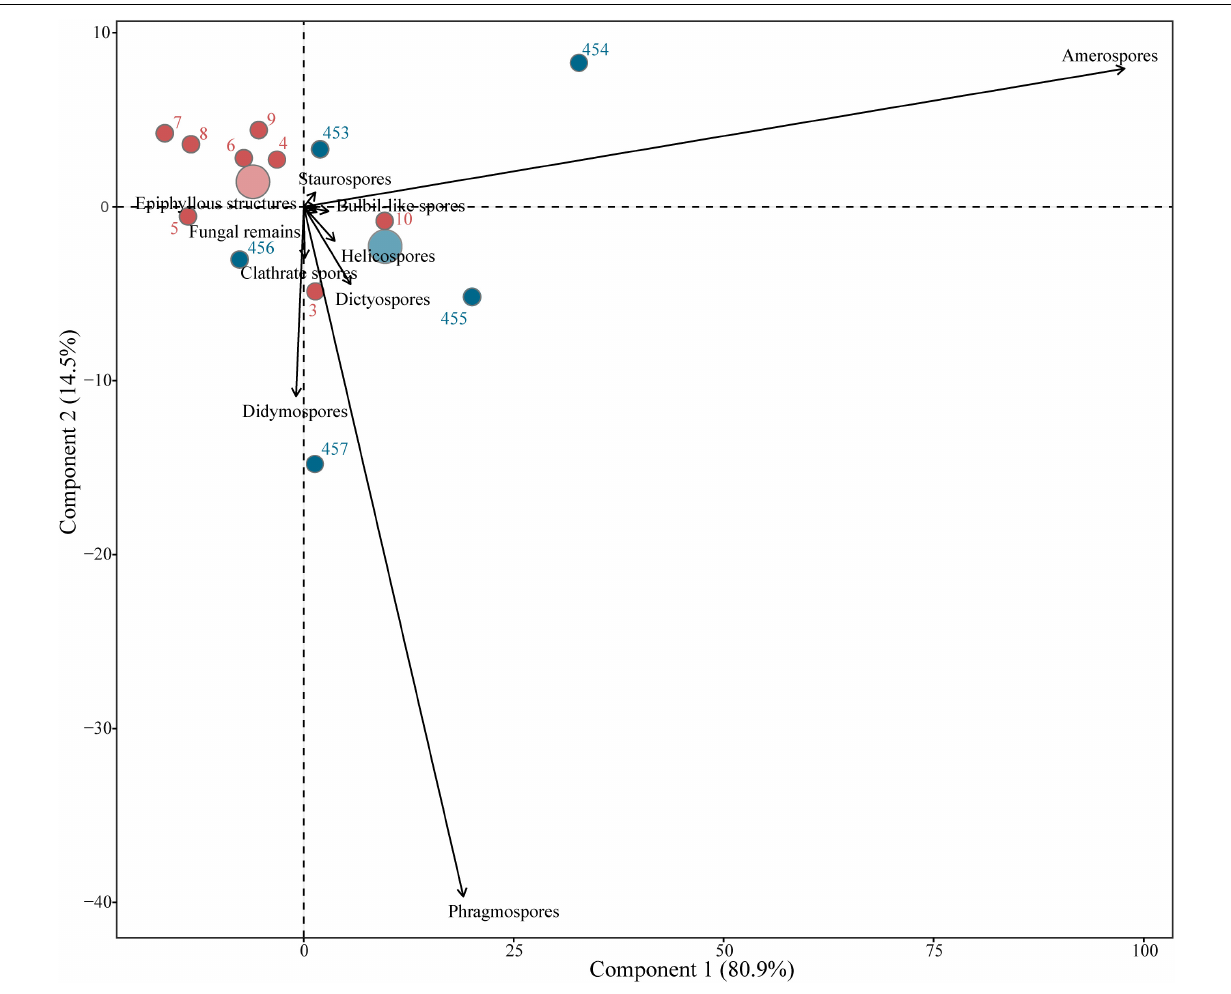
found only in 453 include Megalohypha aff. aqua-dulces